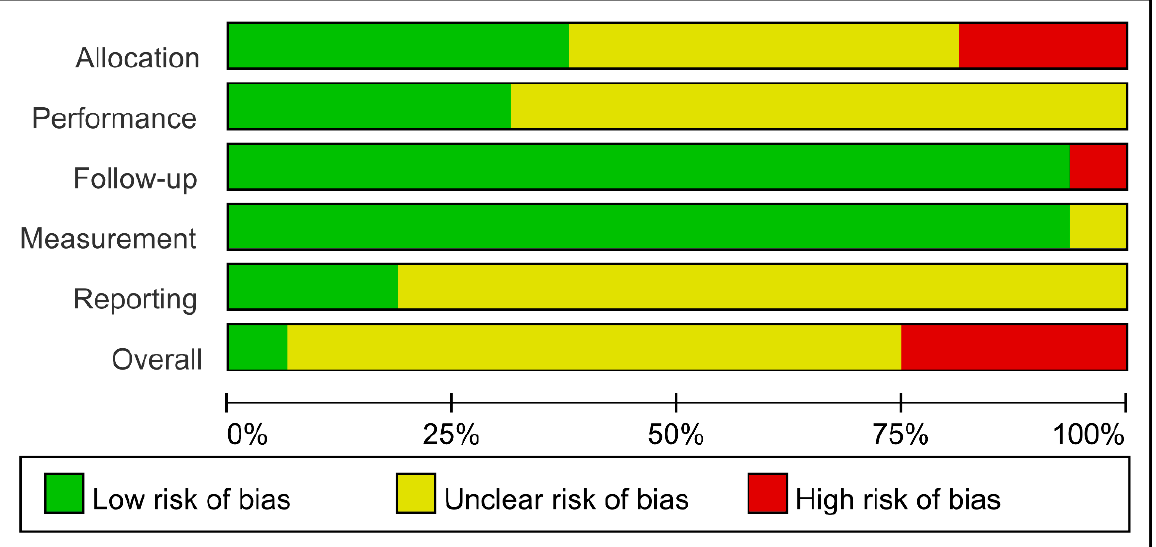
Figure 3. Methodological quality graph: reviews authors’ judgement on each methodological quality item presented as percentage for each included study.